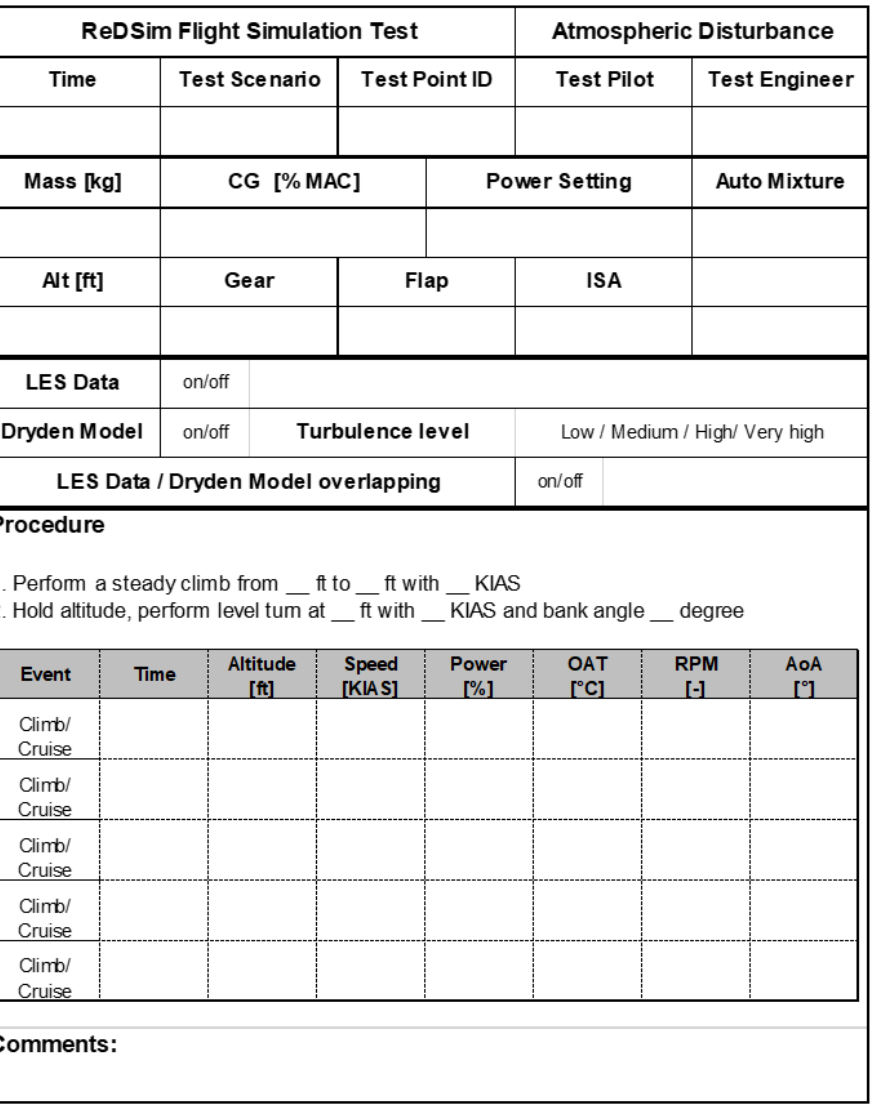
Figure A1. Flight test